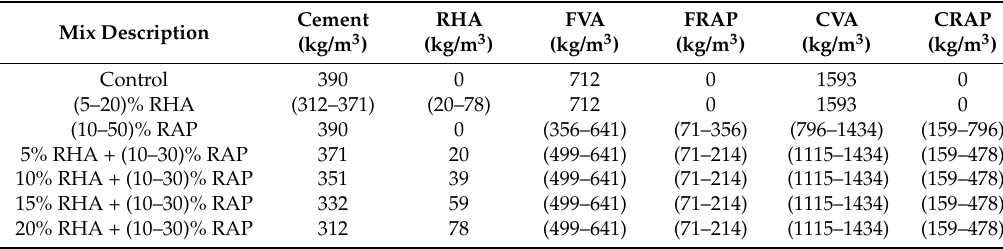
Table 2. Mix proportions for 25 MPa concrete comprising RHA and